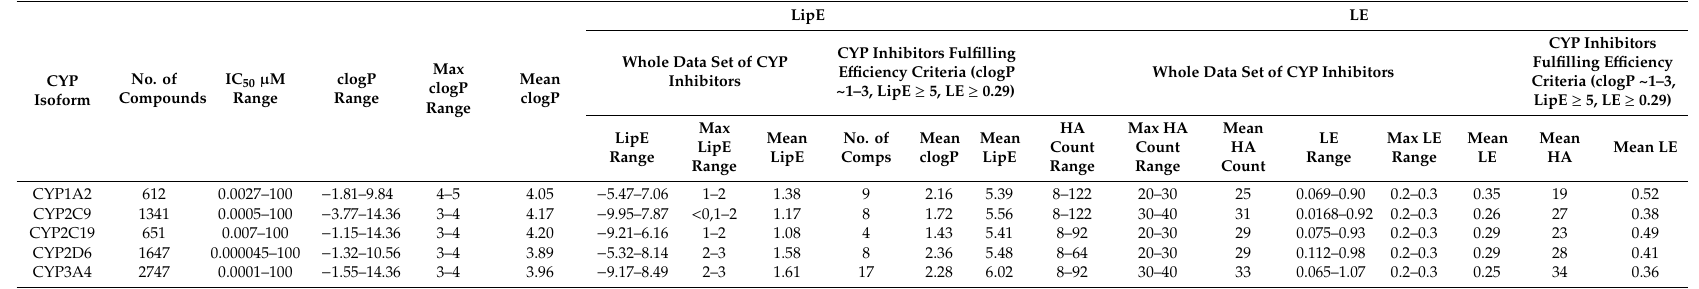
Table 1. The summary of IC 50 , clogP, LipE, heavy atom (HA) and ligand e ffi ciency (LE) ranges for all inhibitors and highly e ffi cient inhibitors of CYP1A2, CYP2C9, CYP2C19, CYP2D6 and CYP3A4 that fulfill the e ffi ciency criteria of clogP ~1.0–3.0, LipE ≥ 5 and LE ≥ 0.29.